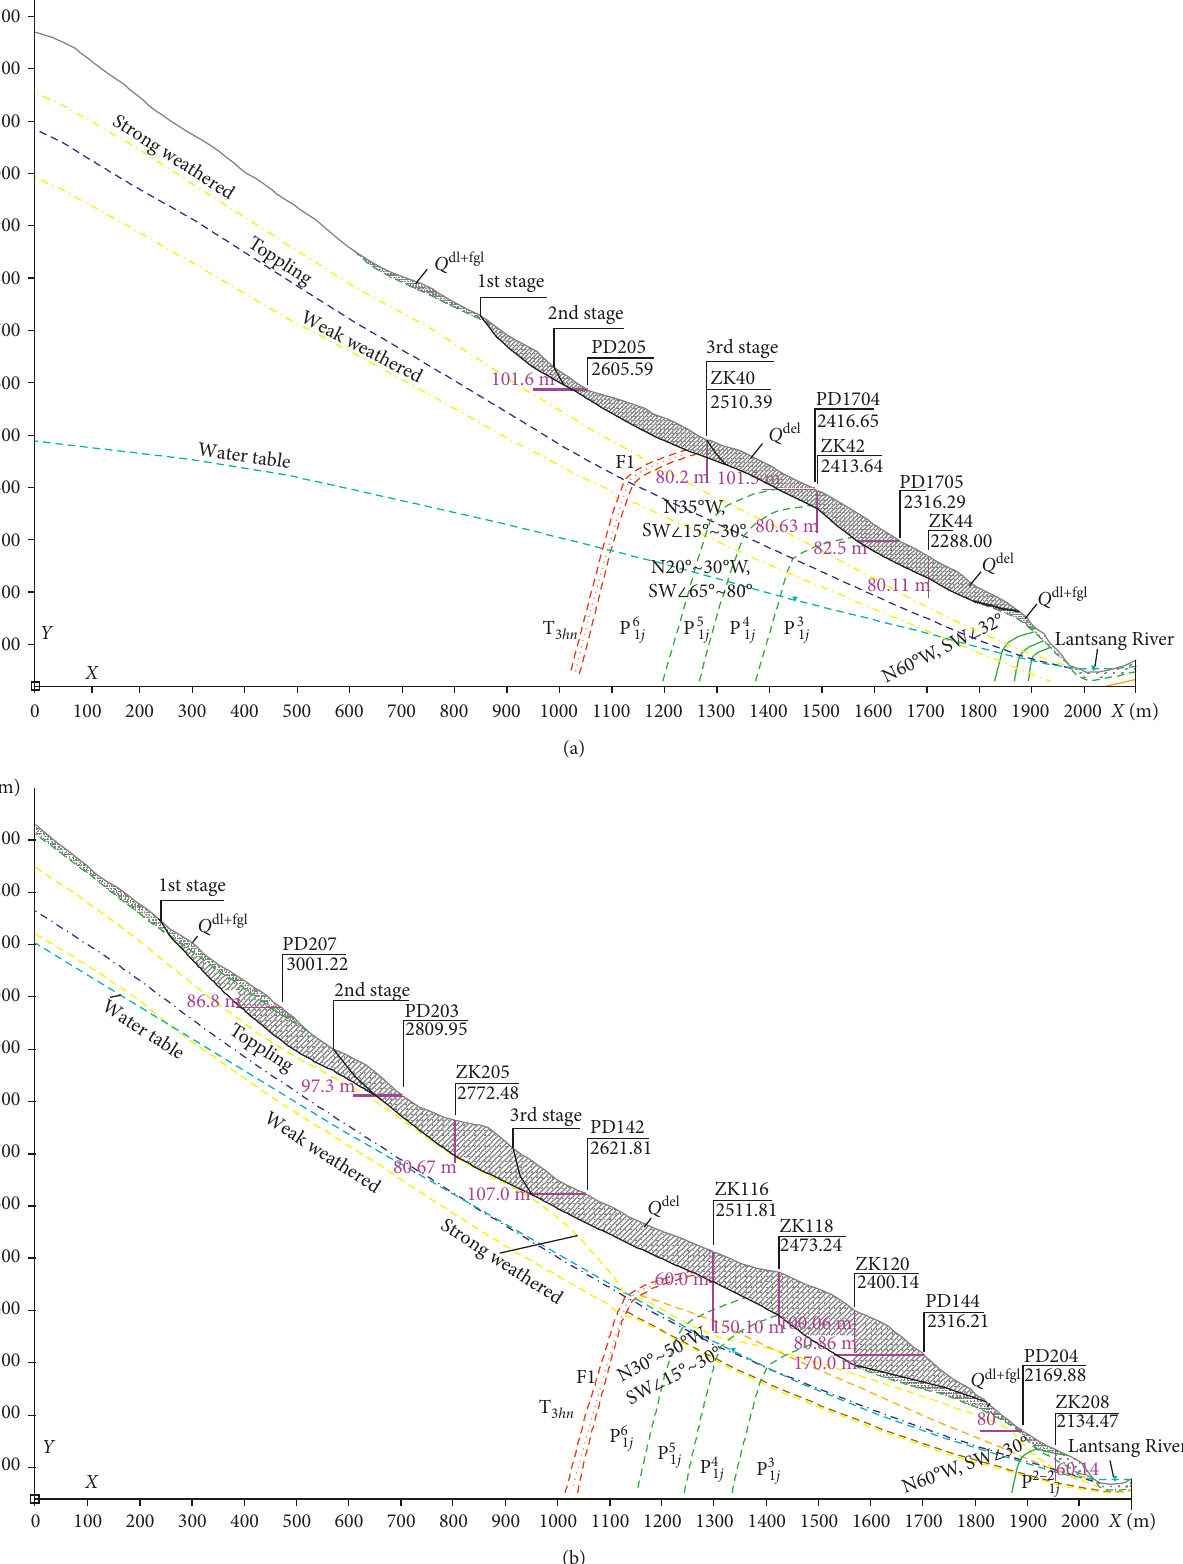
in Zone I; (b) B-B in Zone ′ ′